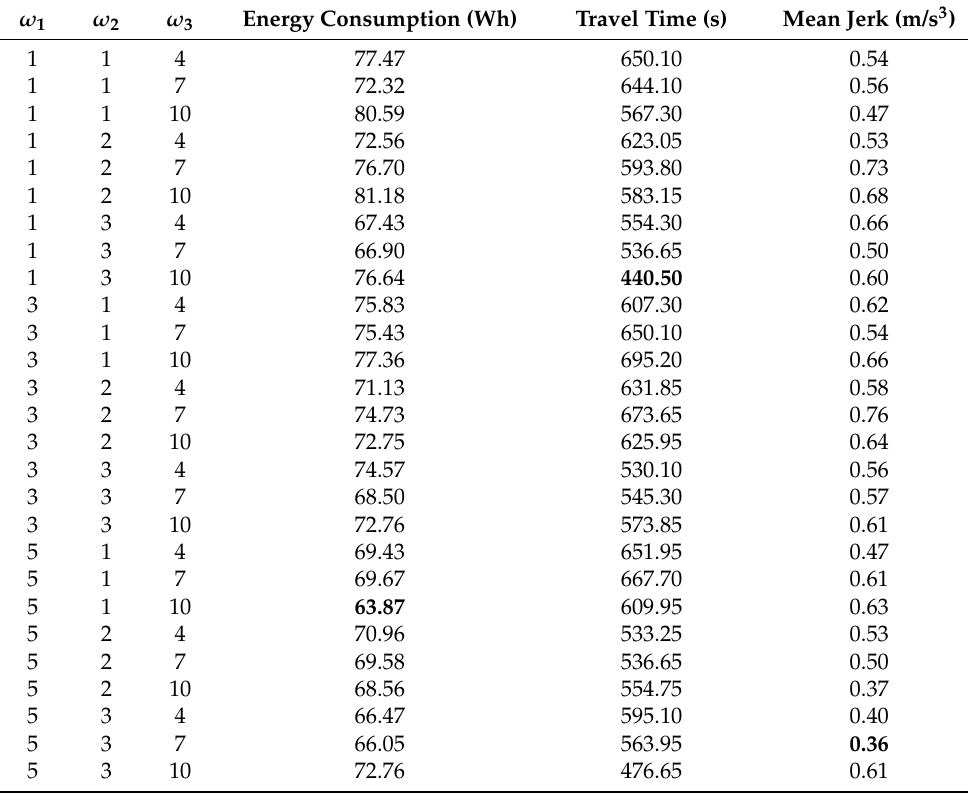
Table 2. Results for different weighting parameters